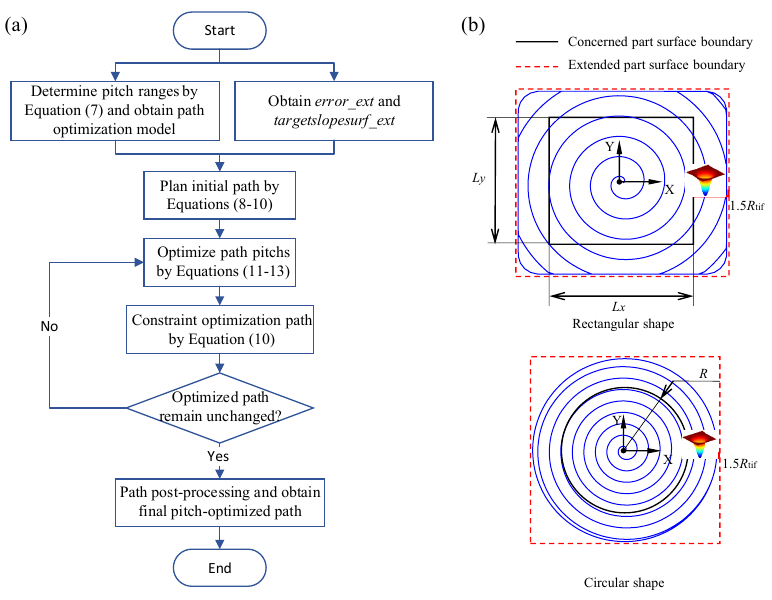
Figure 7. ( a ) The generation flowchart of the optimized path with variable pitch; ( b ) control strategy for edge-warping